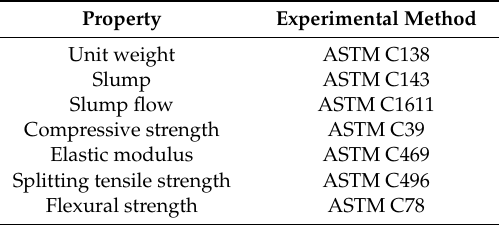
Table 6. Concrete property test